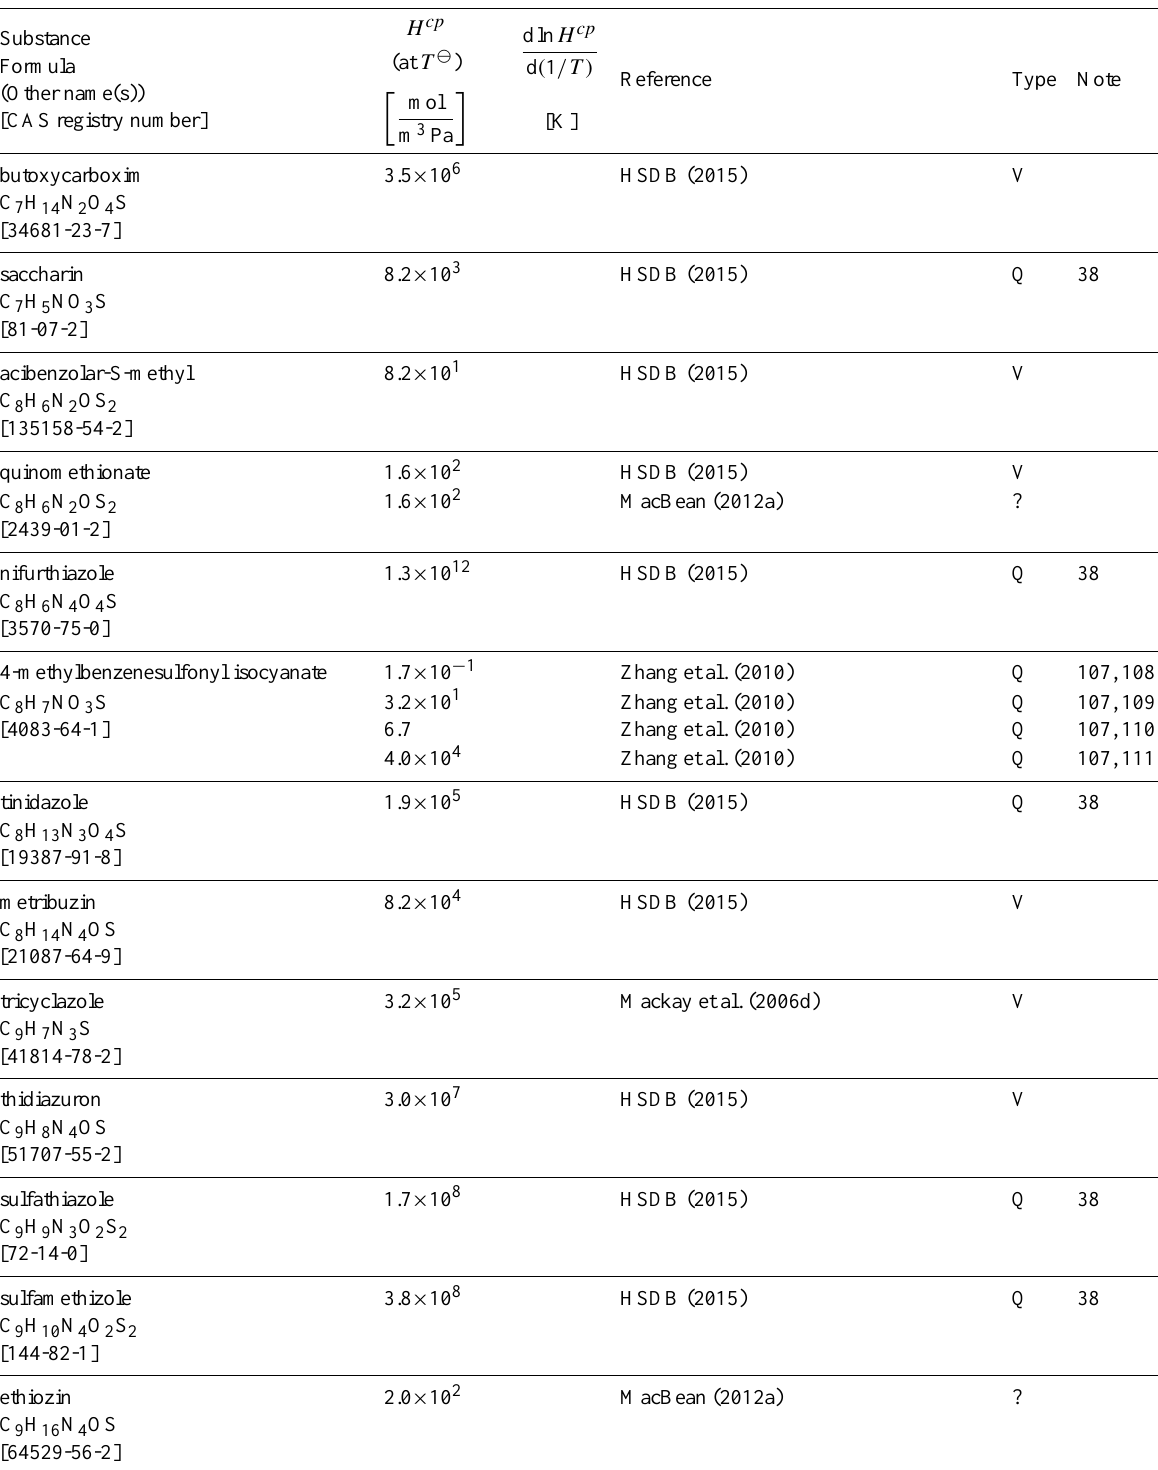
Table 6: Henry’s law constants for water as solvent